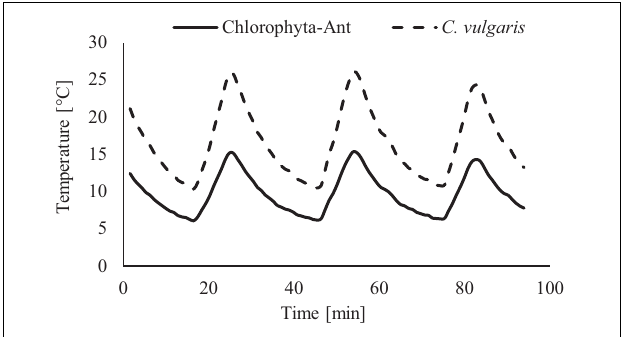
FIGURE 3 | Temperature profile used for Chlorophyta-Ant and C . vulgaris , representative of spacecraft thermal loops.